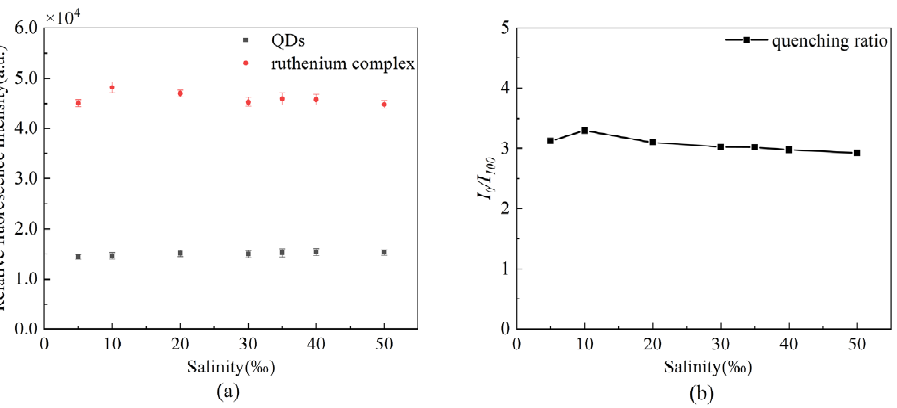
Figure 11. Stability of the oxygen sensor under different salinities ( a ) changes in fluorescence intensity of the two fluorescent dyes, ( b ) changes in fluorescence quenching ratio.